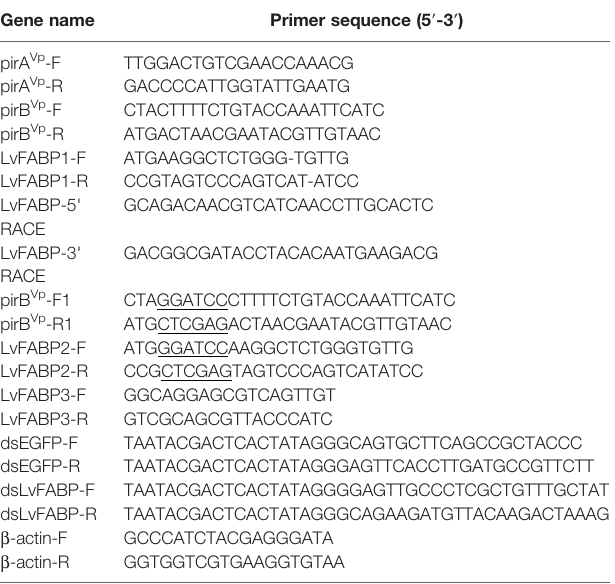
TABLE 1 | The primers of candidate genes used for real-time quantitative PCR (qRT-PCR), RNAi and gene